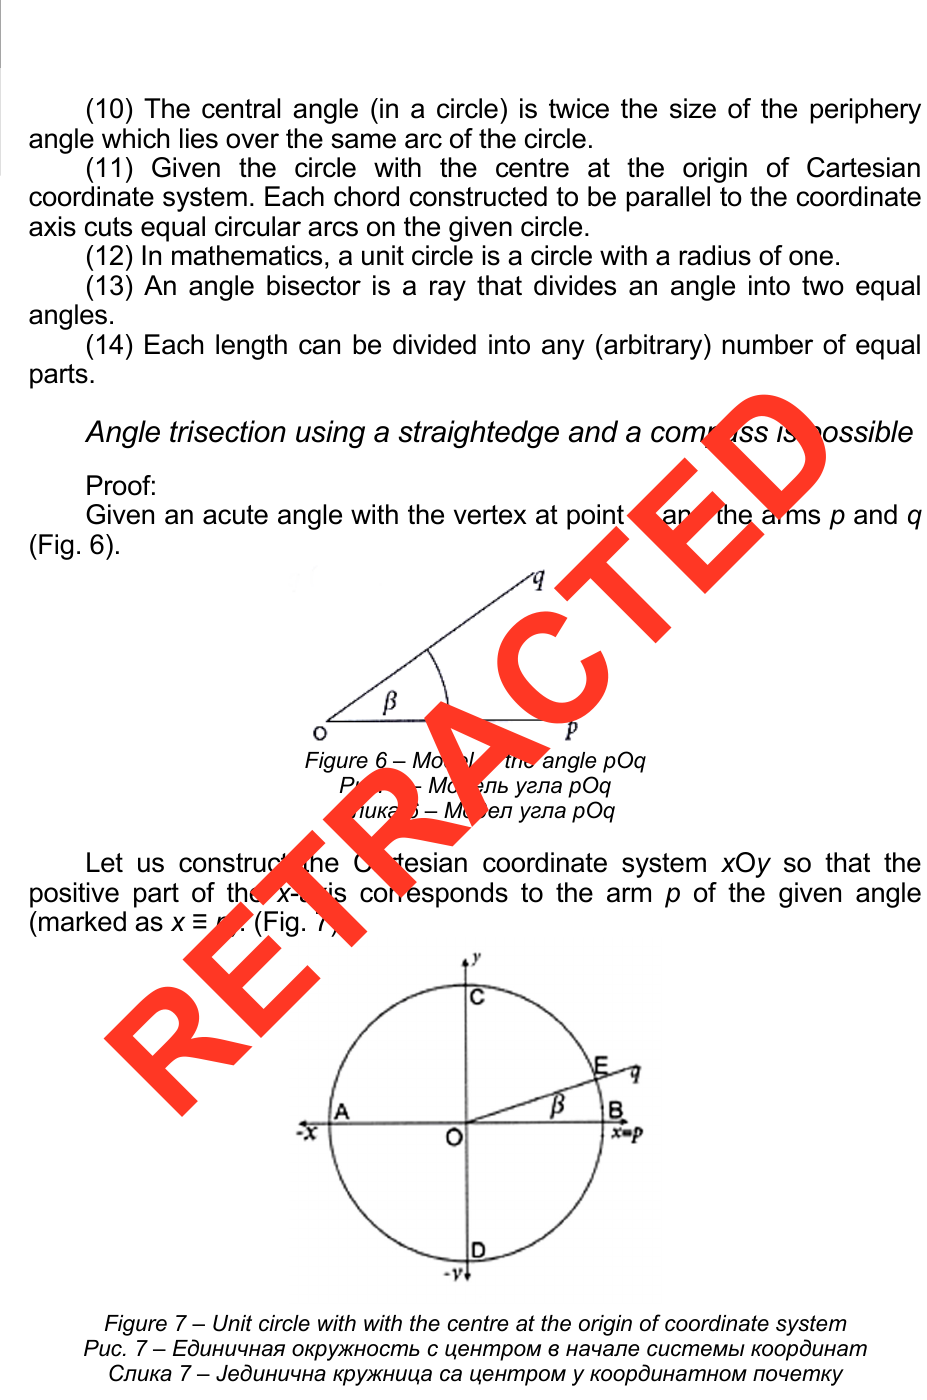
Figure 7 – Unit circle with with the centre at the origin of coordinate system Рис . 7 – Единичная окружность с центром в начале системы координат Слика 7 – Јединична кружница са центром у координатном